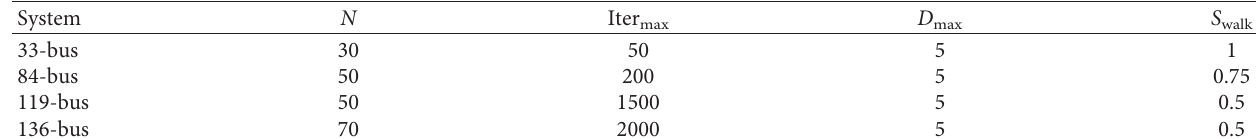
Table 1: The parameters of CSFSA for test systems.